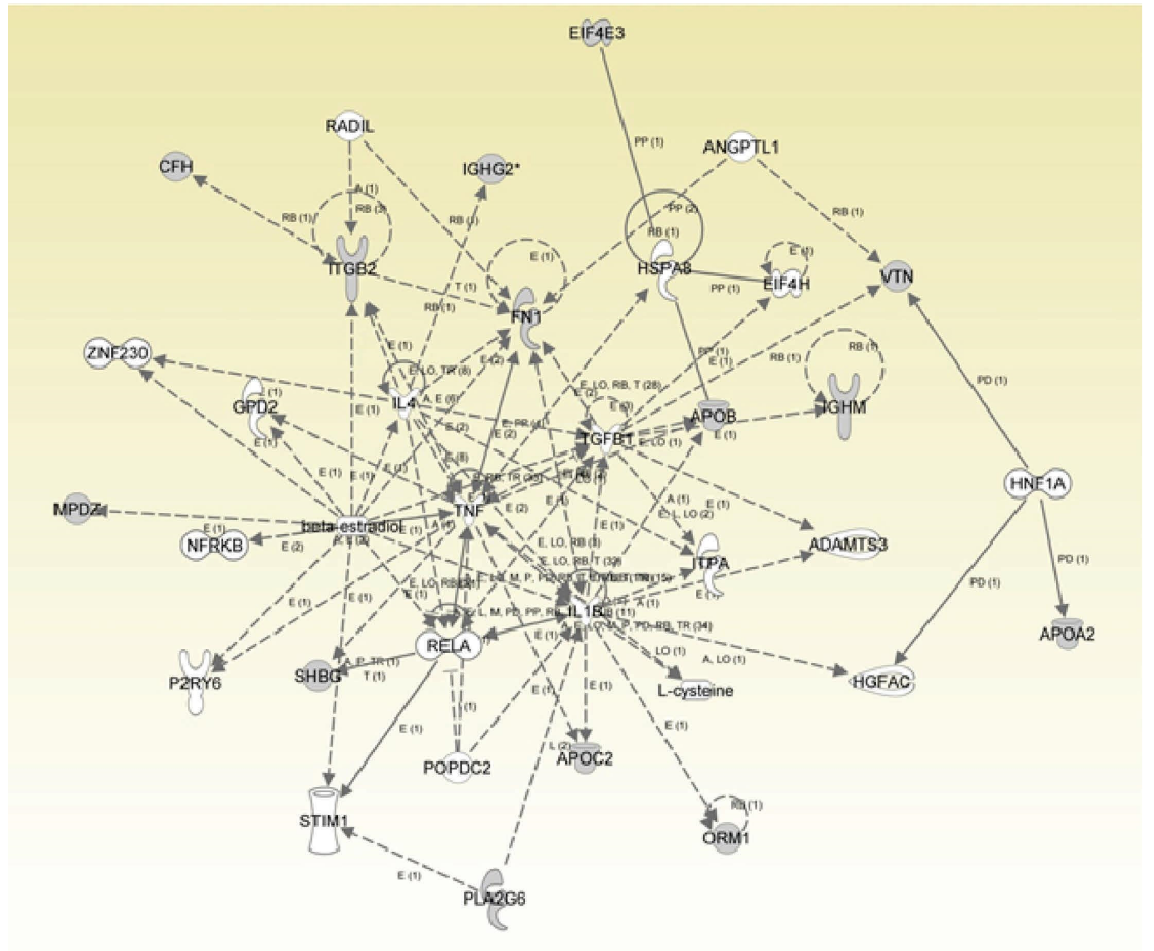
Figure 4: Pathway analysis of network signaling of 32 proteins represented in the ingenuity pathway analysis database included 14 PPs identifed in this study (grey shading). Only thirty-two (32) of the 100 proteins were mapped in the IPA database and were implicated in the pathway analysis of multiple signaling networks including cell-to-cell signaling and interaction, cell death and survival, cellular movement, and immune cell trafcking (the image was generated using ingenuity pathway analysis program (IPA version 49:309) https://qiagen.force.